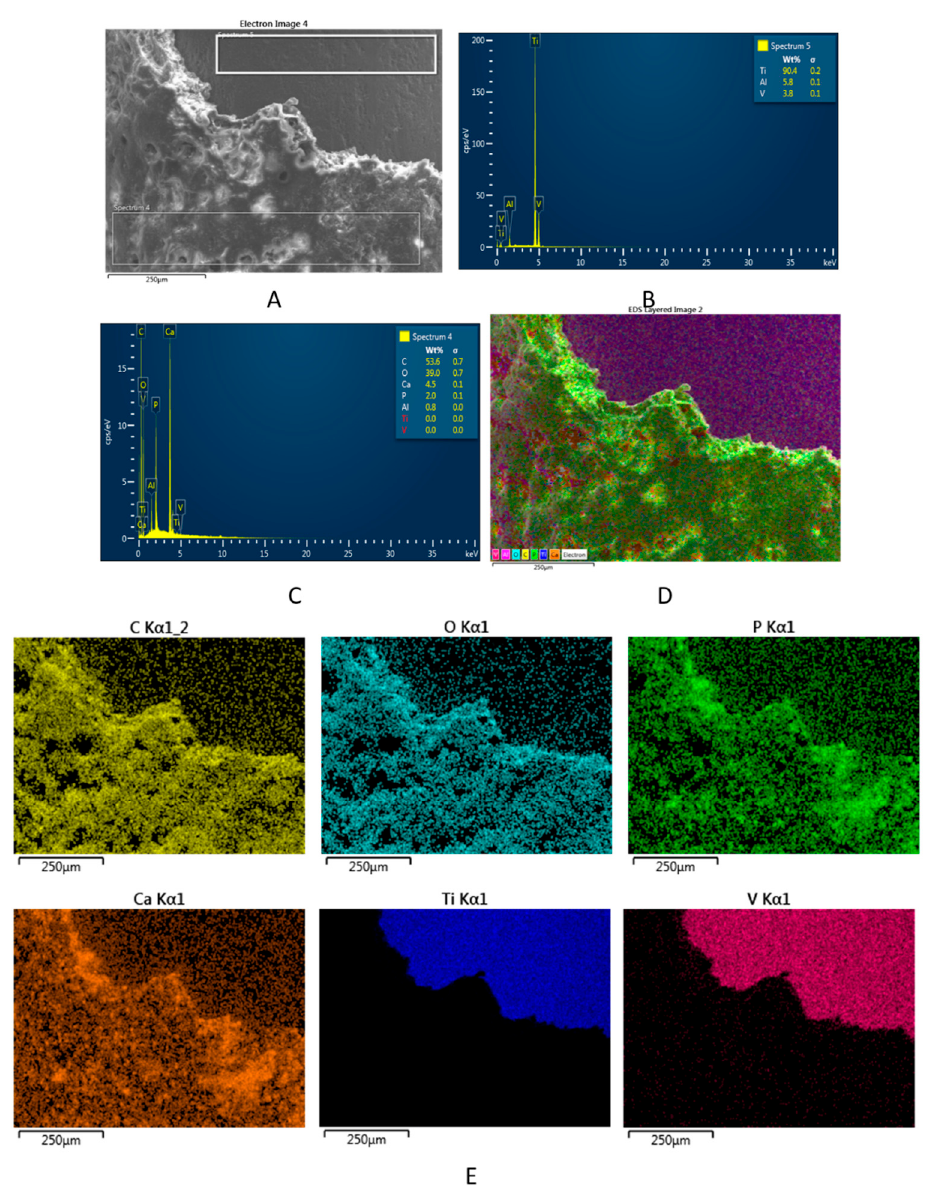
Figure 8. ( A ) FE-SEM image and EDX spectra of the ( B ) Ti implant surface and ( C ) bone–BCSTi implant interface without HF-PESW biophysical stimulation. ( D ) Multicolor distribution map showing the elements jointly on the FE-SEM image, followed by the distribution maps ( E ) of the individual elements.